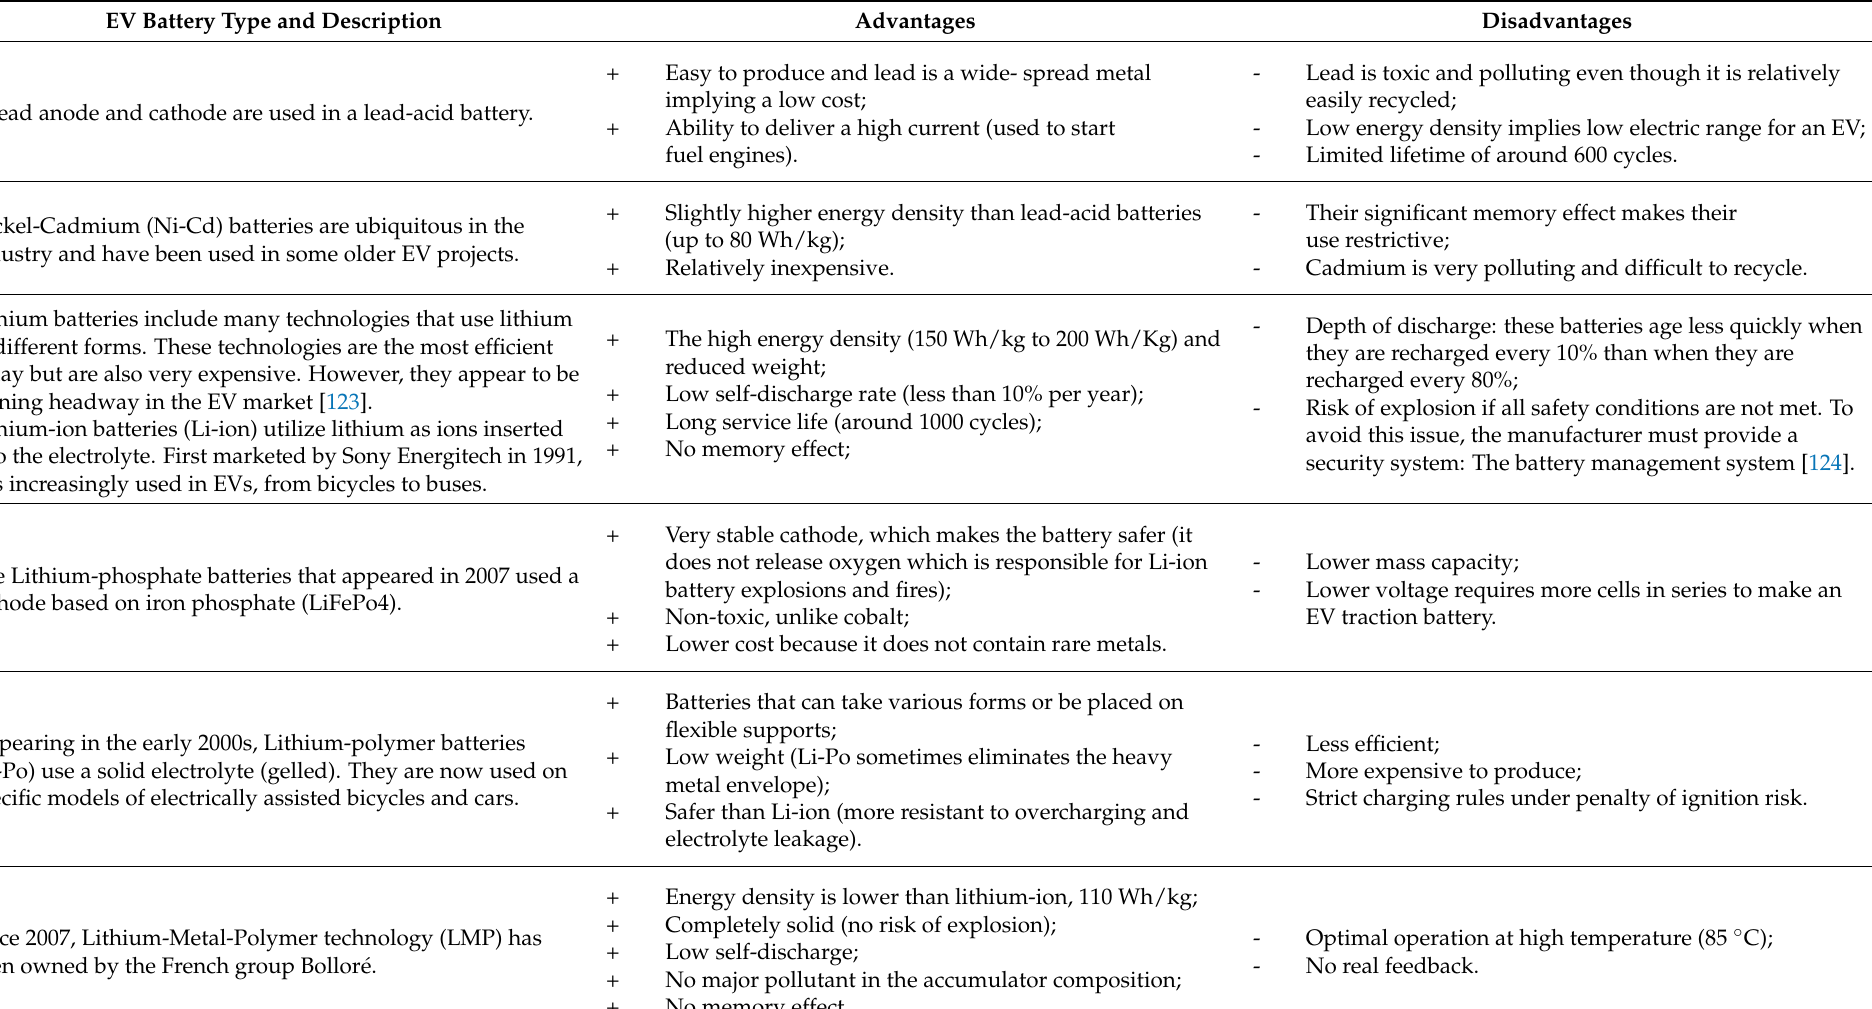
Table 11. The EV batteries